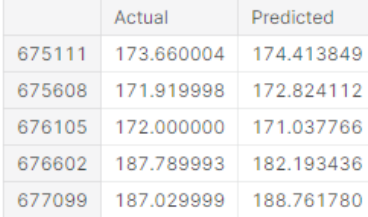
Figure 13. Comparison of Accuracies between ML Models for the prediction of Close